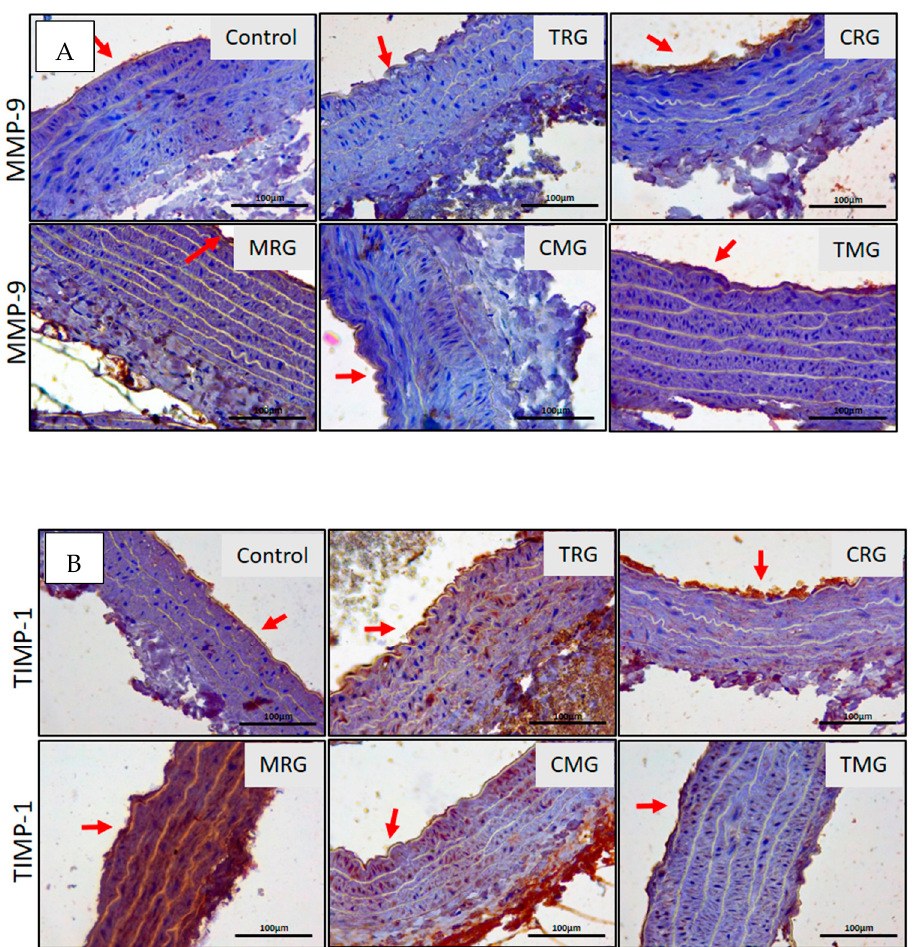
Figure 6. Immunolocalization of MMP-9 ( A ) and TIMP1 ( B ) in wall of aorta in all groups of animal. Red arrows indicate aortal intima. IHC A and B. Objective magn. ×40; bar 100 μ m.